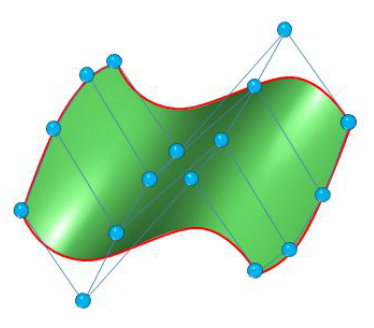
Figure 10. B-spline